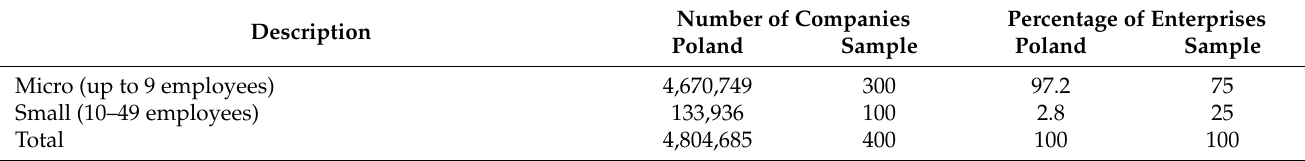
Table 1. Population and sample structure of enterprises by employment size.